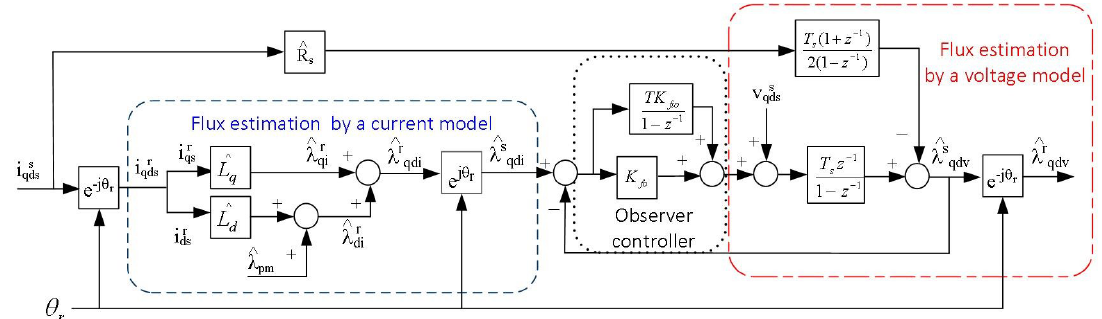
Figure 4. A block diagram of a stator flux linkage observer used for DB-DTFC ( deadbeat-direct torque and flux control ) implementation [25].